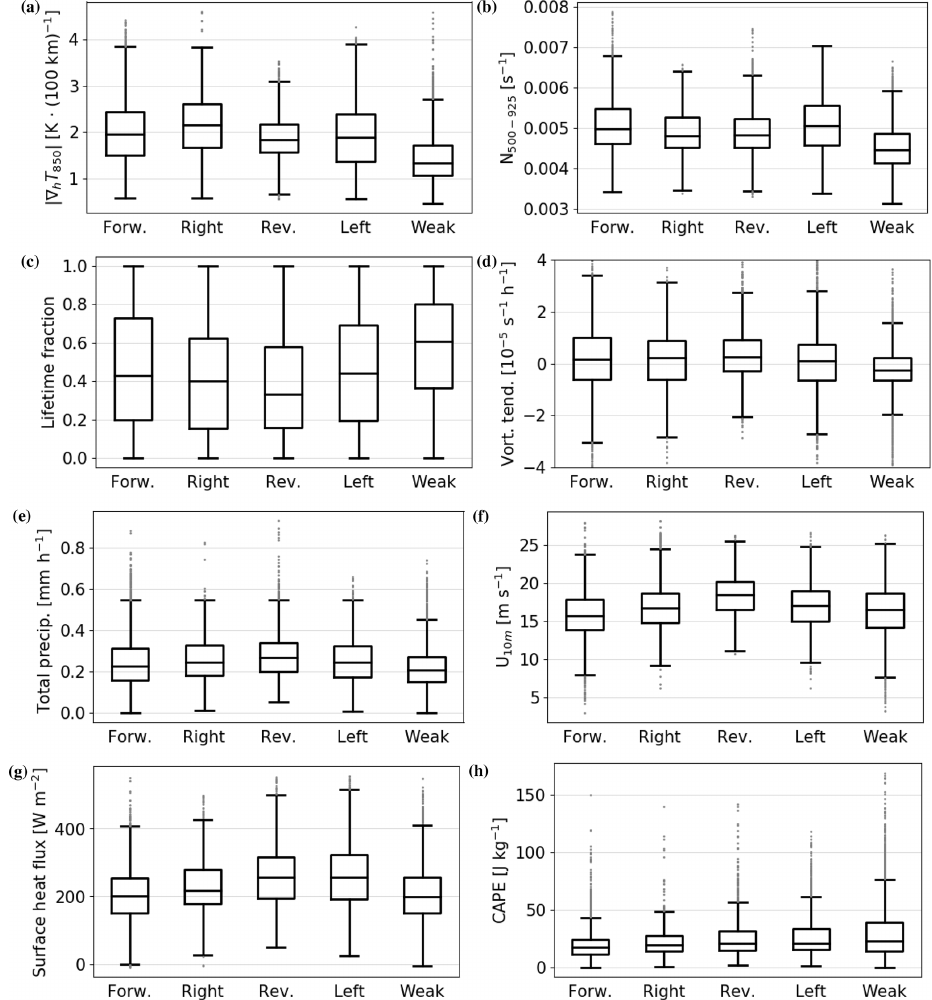
Figure 5. Distributions of different parameters for all time steps attributed to the shear categories introduced in Fig. 4. The vorticity tendency is derived as described in Sect. 2.4. The lifetime fraction is given by the time step of a PL divided by its lifetime. For the other parameter, the mean value within a 250km radius is calculated, except for the 10m wind speed, where the maximum is applied. For the computation of the mean static stability, total precipitation, surface heat fluxes, and CAPE, grid cells covered by land or sea ice are